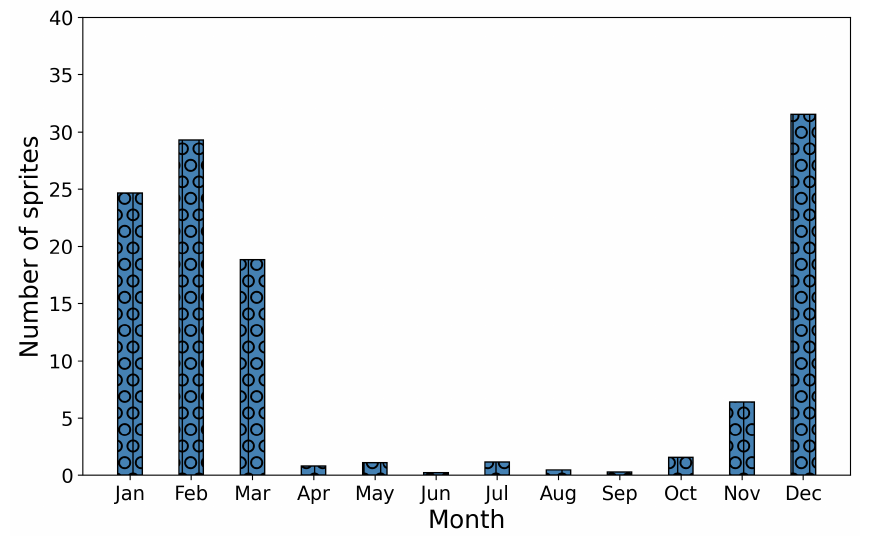
Figure 11. Estimated monthly number of sprites in case B (see caption of Table 1 for an explanation of the three different